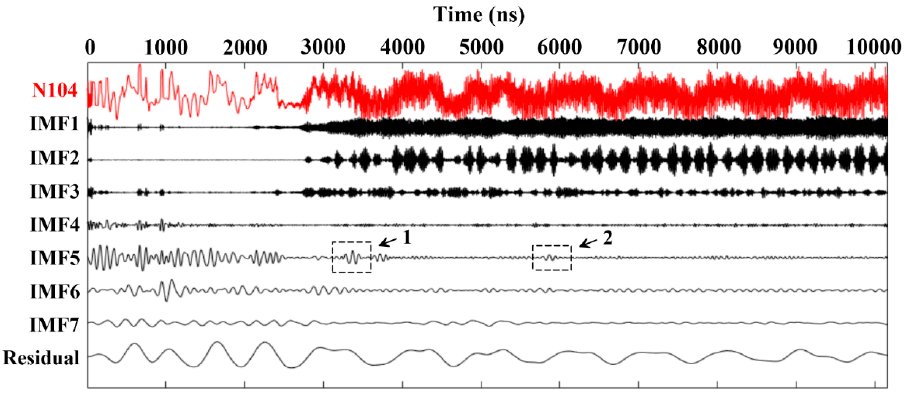
Figure 7. Analysis of the trace at N104 by complete ensemble empirical mode decomposition (CEEMD).